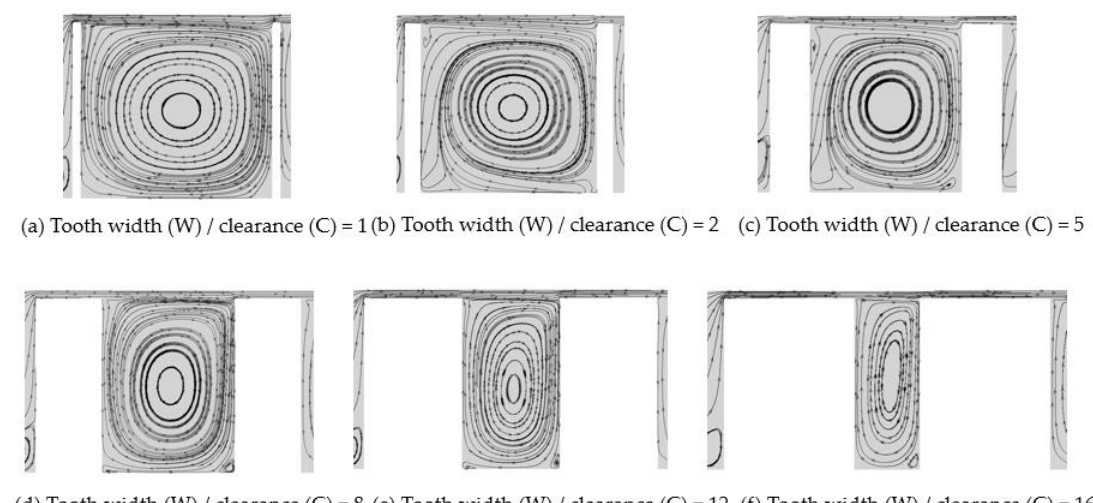
Figure 17. ( a – f ) The effect of changing the tooth width to clearance (W/C) ratio on the streamlines of a straight-through labyrinth seal.